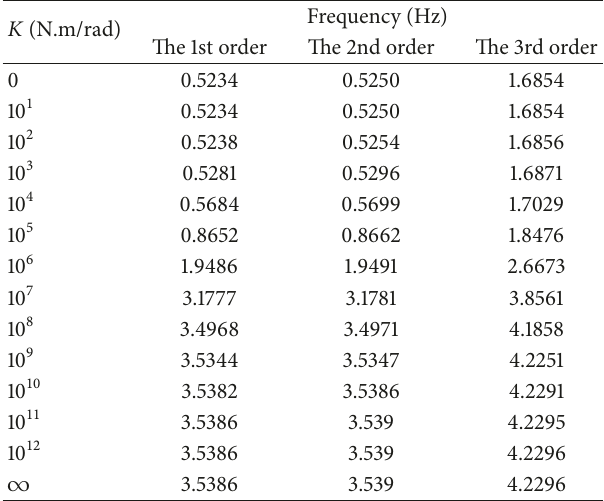
Table 3: Effect of rotational stiffness of CFJ on structural natural